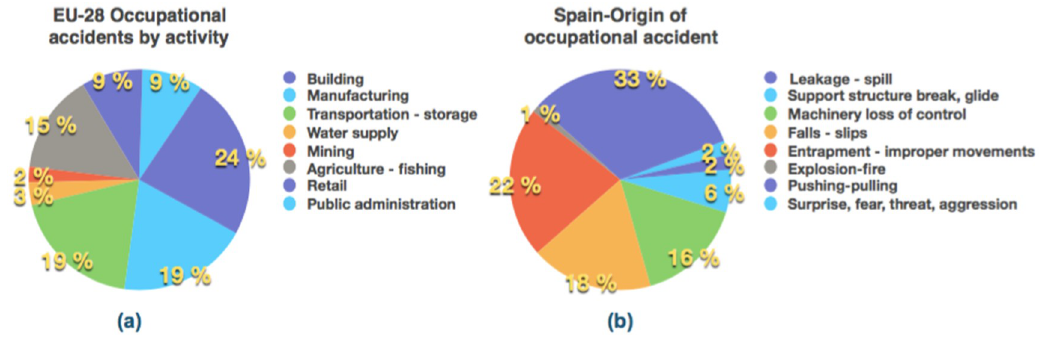
Figure 1. ( a ) Accident rate by activity in the year 2015 in the EU-28 countries of the European Union (adapted from [1]); ( b ) description of origin of occupational accidents in Spain for years 2014–2018 (adapted from [2]).